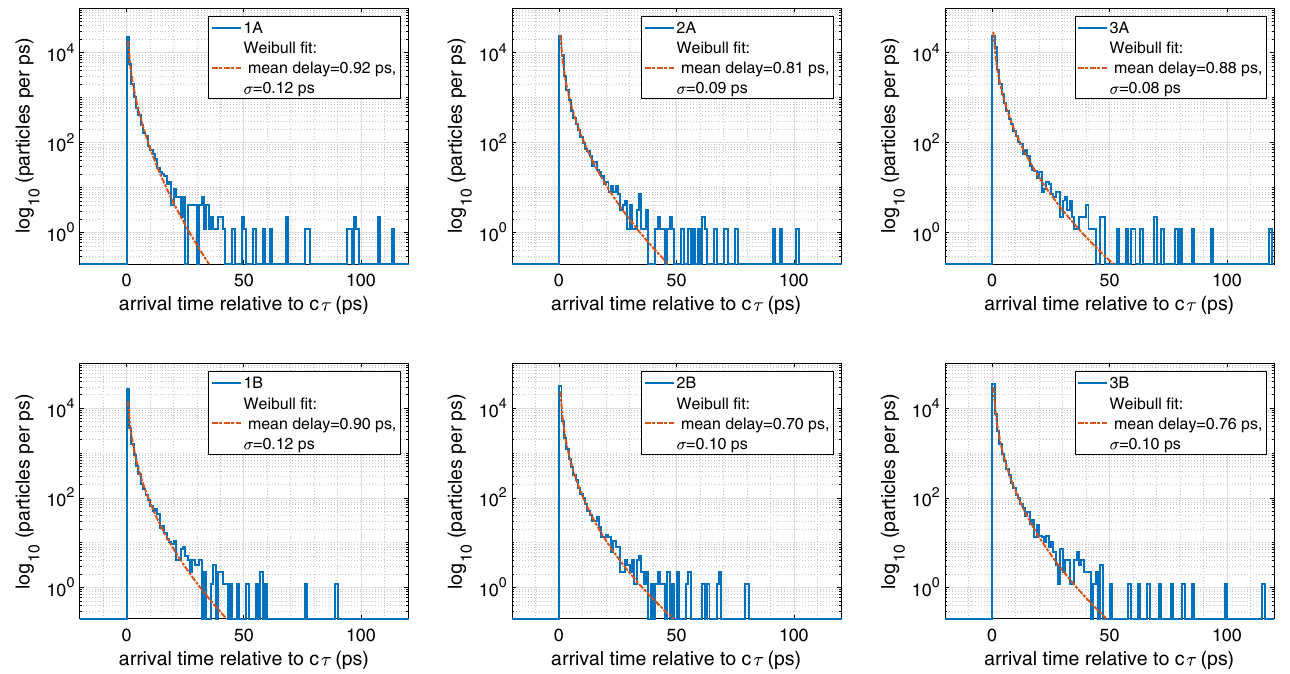
FIG. 22. GEANT 4 -simulated time delay distributions of 100 GeV photon-initiated shower particles, through 3.5 radiation lengths of material, relative to the light travel time from the injection point, along with fits of a Weibull probability density. Each of the panels shows the delay spectrum and fit for one of the simulated waveguide elements, with alphanumeric indices giving their position in the six- element stack of three dual-waveguide detectors. Thus 1A and 1B are the individual waveguides in the first dual-element pair, with A in front and B in the rear relative to the shower